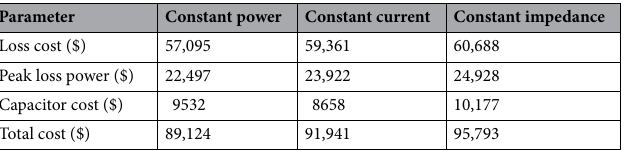
Table 15. Different amounts of cost in the network after the capacitor placement in the mode of